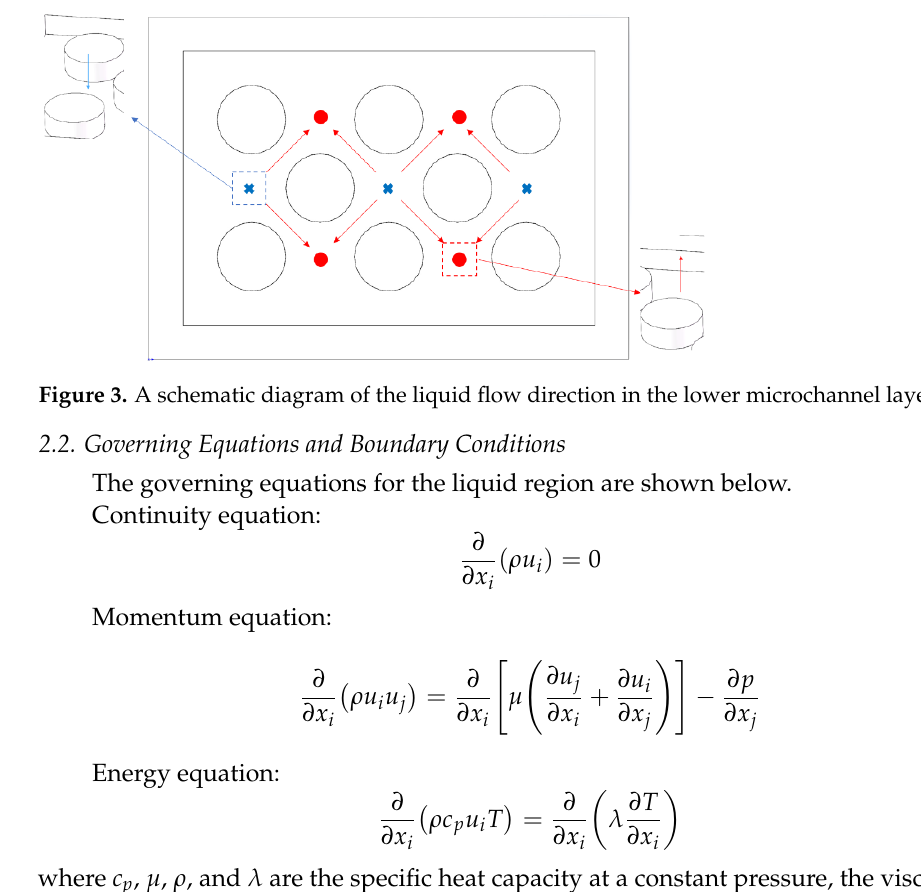
Figure 2. The structure of the double-layer pin–fin MMC.